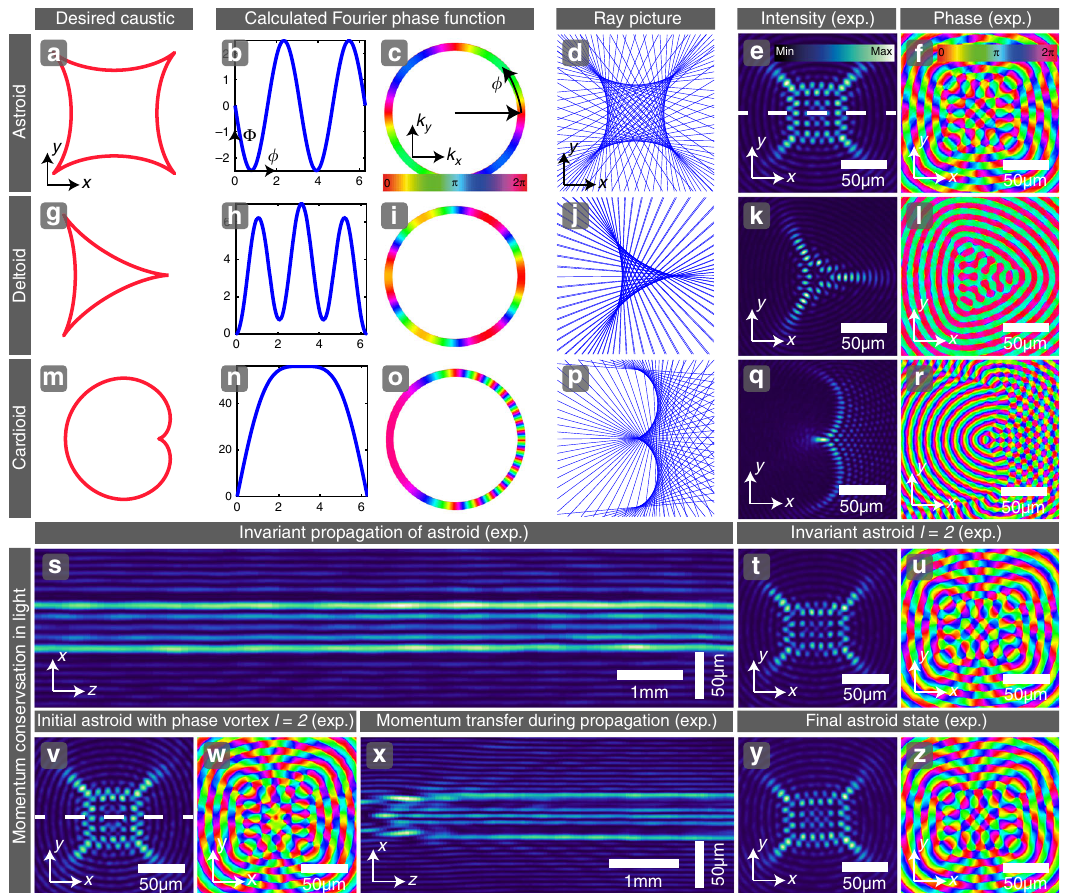
Fig. 2 Engineering desired caustics in light, demonstrating their propagation invariance and momentum conservation. a – f Astroid. a Desired caustic. b 1D phase function. c Phase function mapped onto 2D Fourier ring. d Transverse projection of the rays. e , f Experimentally measured transverse intensity and phase. g – l Deltoid. m – r Cardioid. s Invariant propagation of the astroid from image ( e ), xz -cross-section through the intensity volume. t , u Invariant astroid with charge ℓ = 2. v – z Self-healing/momentum transfer in astroid: v , w Diffractive astroid, initial fi eld with phase vortex of charge ℓ = 2. x Propagation showing diffraction and transfer to fi nal OAM state. y , z Momentum transfer to fi nal astroid state same as ( e , f ), which then propagates